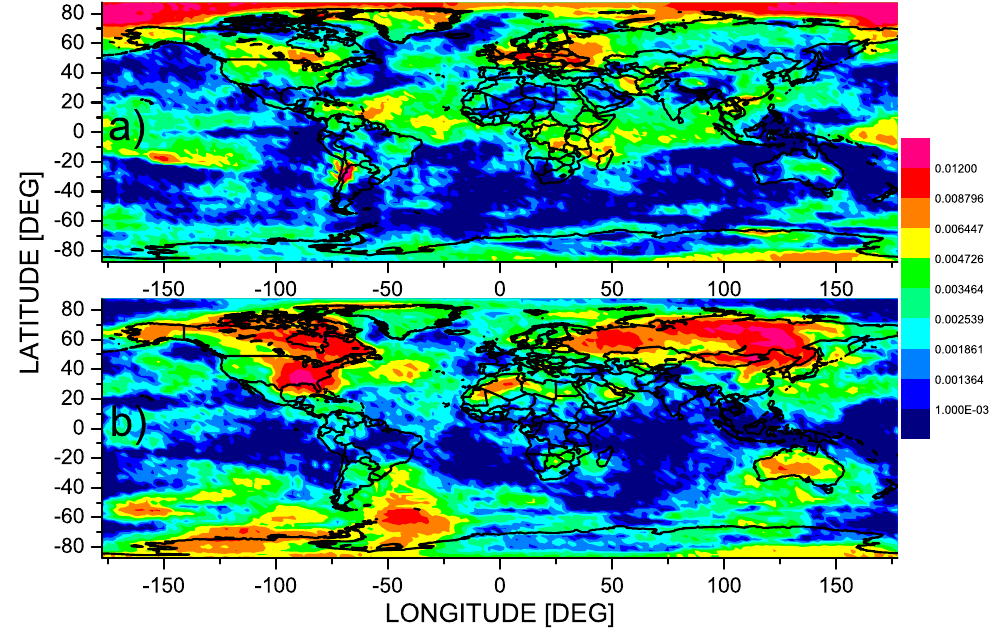
Fig. 13. Area weighted connectivity for SATA climate networks with density % = 0 . 005 obtained by thresholding of the absolute correlations Z -scores related to independent univariate FT surrogate data for low (a) and high (b) solar activity as measured by the 10.7cm solar radio